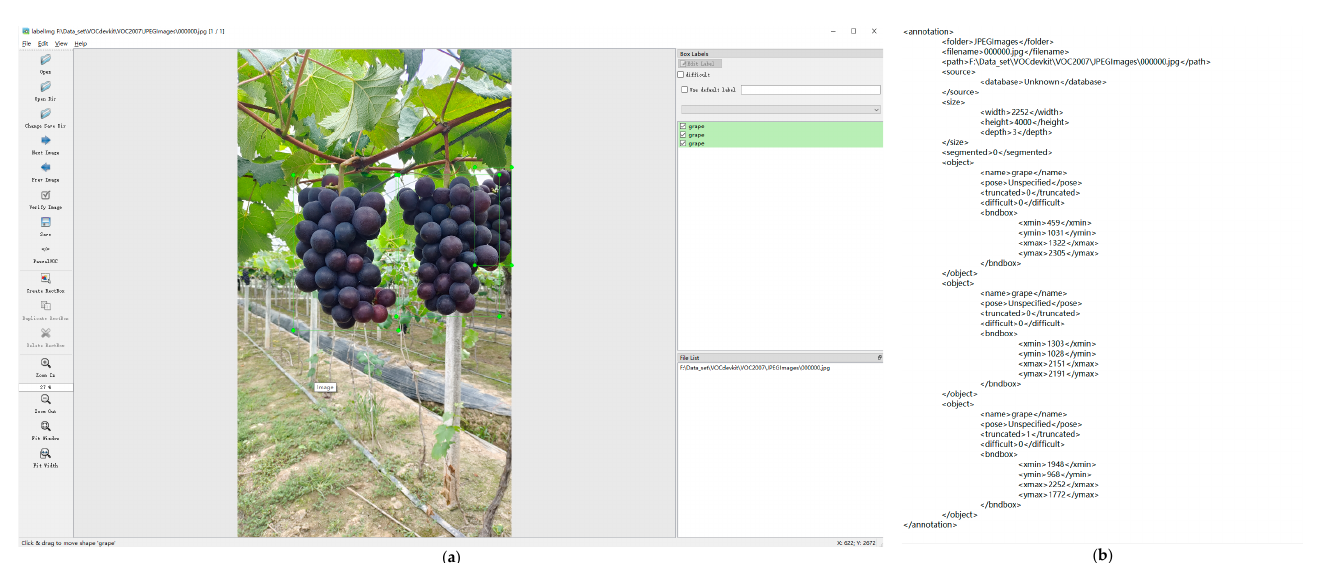
Figure 3. ( a ) LabelImg software; ( b ) XML label file.